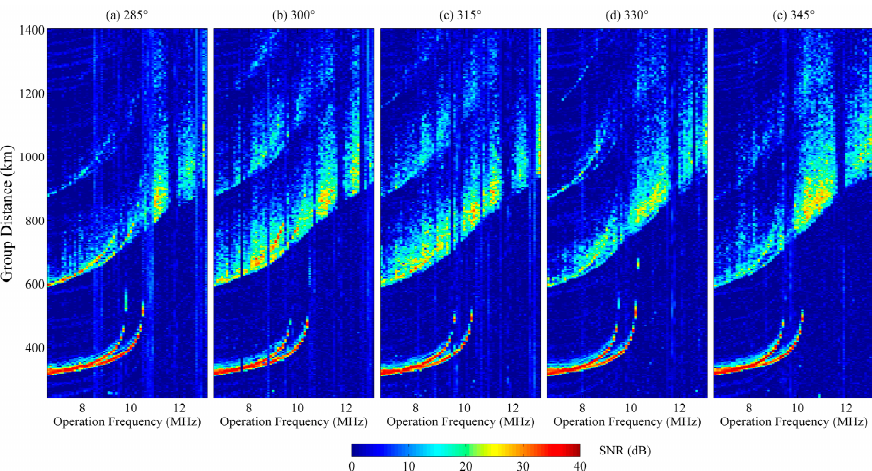
Figure 11. Swept-frequency oblique backscatter ionograms of WIOBSS-AA with five different beams, ( a ) 285°, ( b ) 300°, ( c ) 315°, ( d ) 330°, and ( e ) 345° in a clockwise manner. The operating frequency is